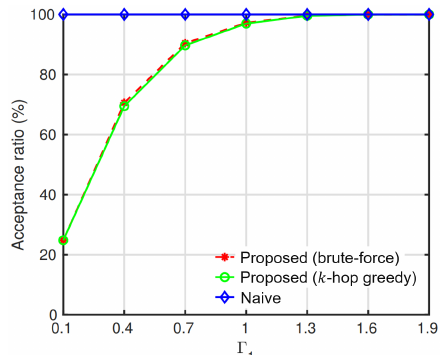
Figure 3. Acceptance ratio of the low-priority slice by the interference threshold of the high-priority slice ( Γ 1